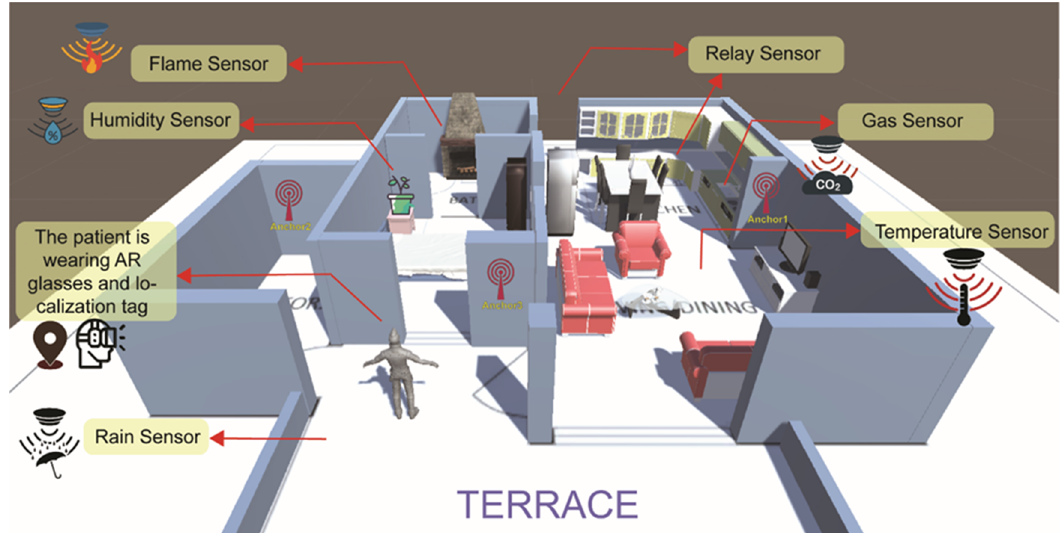
Figure 3. The general model of the AAL system in the older adult’s home environment is illustrated by the Unity game engine as an example. The location of IoT devices, indoor positioning anchors, and the user with an AR device is shown.